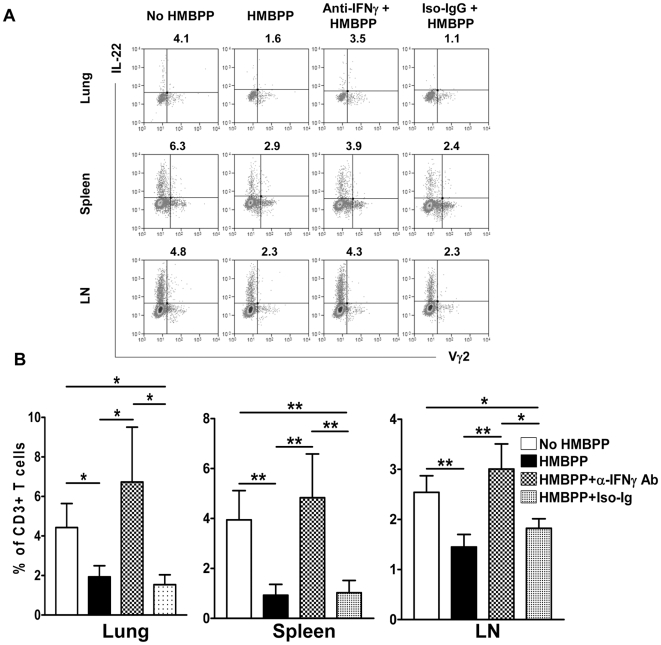
Anti-IFNγ neutralizing Ab treatment reversed the HMBPP-mediated down-regulation effect on IL-22-producing T cells.Cells from different anatomic compartments were either un-stimulated or stimulated with HMBPP, HMBPP + anti-IFNγ neutralizing Ab, or HMBPP + isotype matched IgG Ab, and then subjected to intracellular cytokine staining. (A) Representative flow-cytometry histograms from monkey RH7717 (lung), RH7719 (spleen) and RH7720 (mesenteric lymph node) show intracellular cytokine staining data demonstrating that anti-IFNγ neutralizing Ab but not isotype IgG reversed the HMBPP-mediated down-regulation of IL-22+CD3+ T cells in lymphocytes from lungs, spleens and mesenteric lymph nodes (LN). Cells were gated on CD3. Percentage numbers of CD3 T cells are listed above individual histograms. (B) Comparative flow-cytometry data show that anti-IFNγ Ab but not isotype IgG reversed the HMBPP-mediated down-regulation of IL-22+CD3+ T cells in lymphocytes from lungs, spleens and mesenteric lymph nodes (LN). Data were mean ± SEM derived from rhesus macaque animals' lungs (n = 7), spleens (n = 9) and mesenteric lymph nodes (n = 14). *, P<0.05, **, P<0.01. Addition of exogenous IFNγ to PBMC culture was not able to activate/expand Vγ2Vδ2 T cells or to down-regulate mature IL-22-producing T cells (data not shown).